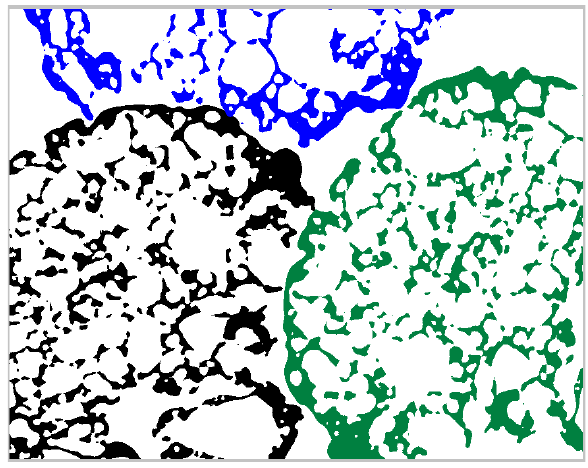
Figure 5. Visualization of the potential dense packing of three particles.